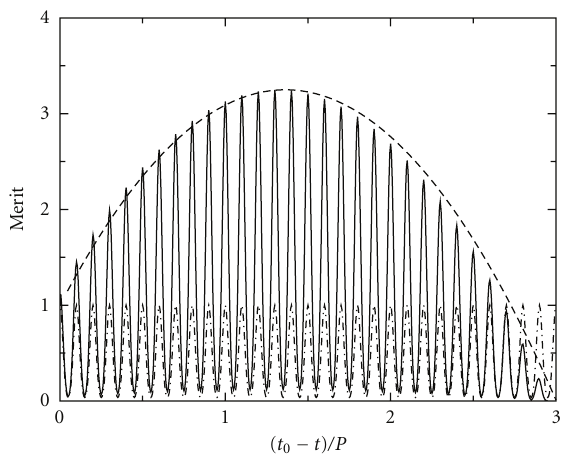
Figure 1: A combination of a long-term increasing and decreasing amplitude function (dashed line) with a high-frequency phase- selection wave (dotted-dashed line) to build a selection merit adequate for scheduling Doppler-imaging targets (thick line).